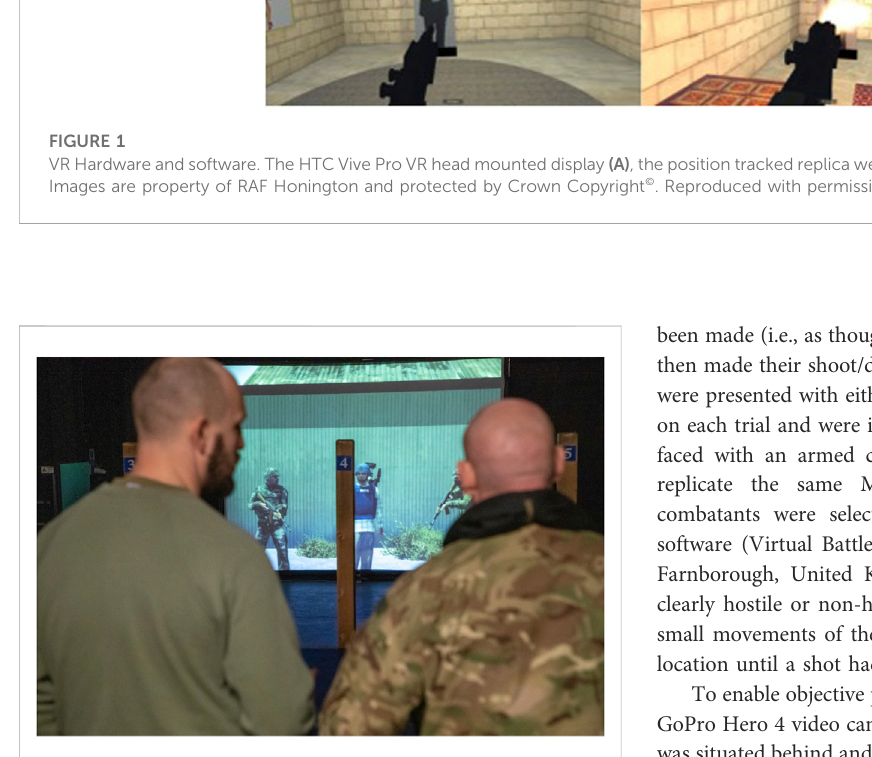
FIGURE 2 2D video simulation condition. The Dismounted Close Combat Trainer. Image is property of RAF Honington and protected by Crown Copyright © . Reproduced with